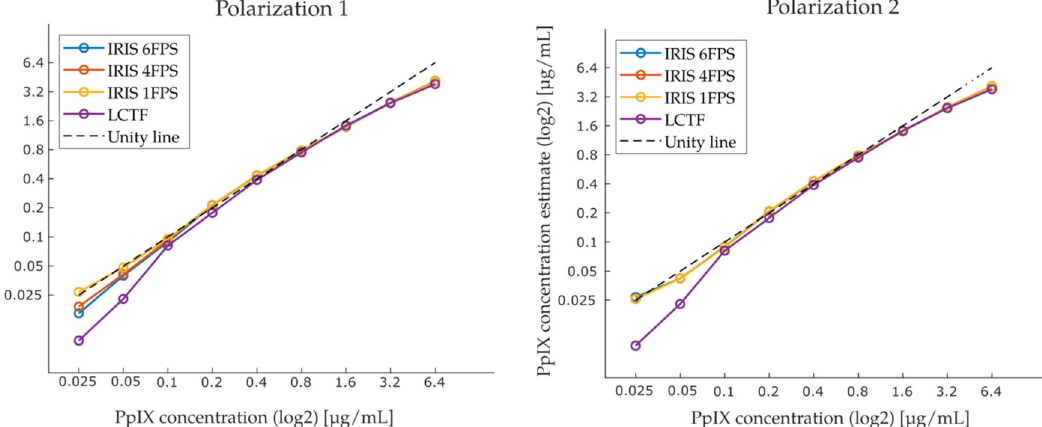
Fig. 3 Imaged PpIX concentrations compared to actual PpIX concentrations in phantoms. Correlation between concentration estimates computed with LCTF and IRIS systems relative to actual phantom PpIX concentrations for both IRIS